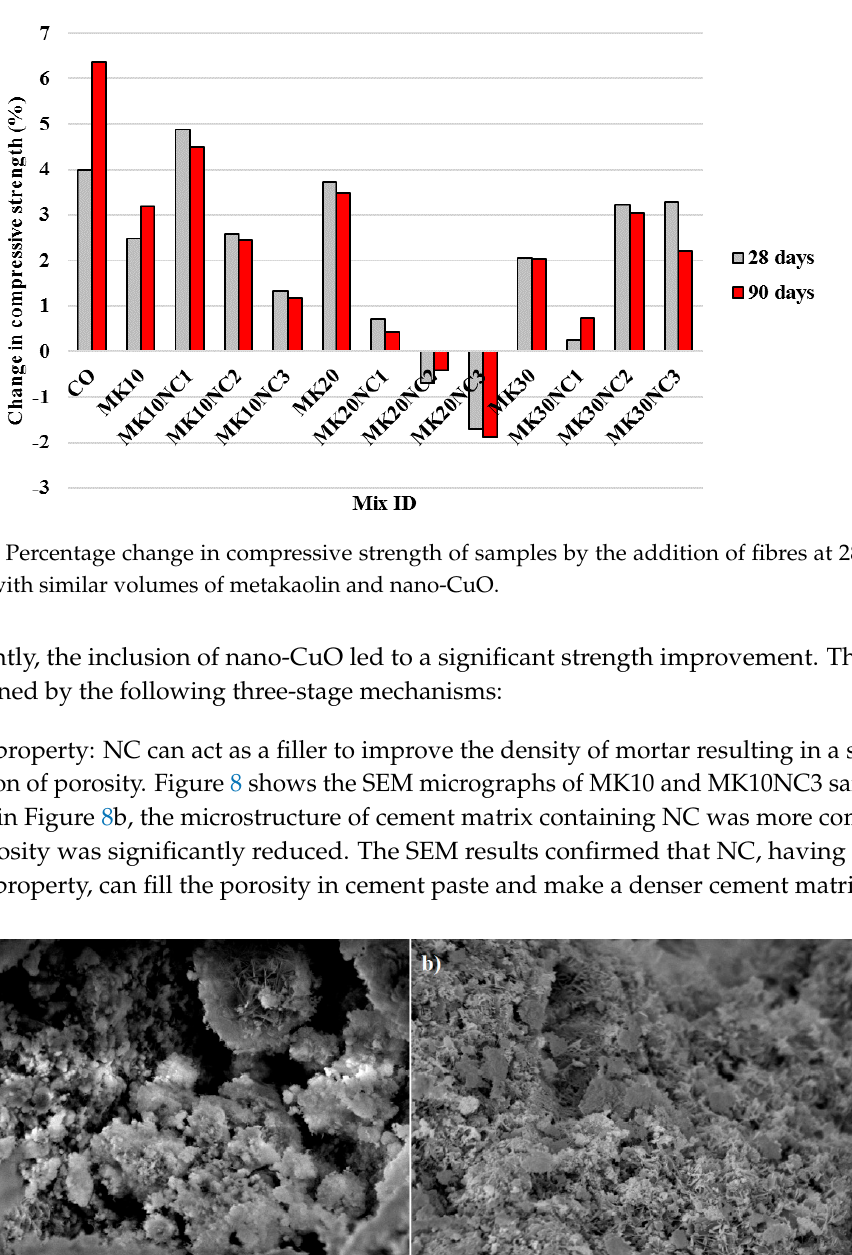
12 of 22 Figure 6. SEM images of: ( a ) CO sample; and ( b ) MK30 sample. According to previous studies, significant reaction between MK and Portlandite (CH) was shown within the interfacial transition zone (ITZ) between aggregate and cement paste. It was reported that the ITZ with a high concentration of large and aligated CH crystals would lead to localized areas of boosted porosity and lower strength [43,44]. Figure 6 shows the SEM micrographs of cement mortar containing 30 wt % MK compared to the control sample. As shown in Figure 5b, the microstructure of cement matrix with MK was more porous containing a large amount of needle- like hydration products cemented together. Moreover, the gap at the ITZ between the aggregate and cement paste found in MK cement sample was much bigger when compared to the control sample, and consequently the cement mortar containing MK showed a reduction in strength. Figure 7 also shows that the compressive strength of cement mortars generally increased slightly when 0.3% PP was used. Although the strengths for mixtures containing 20% MK and 2% or 3% NC were found decreased in comparison with mixes without PP, the average strength for all samples only increased by 2% at both 28 and 90 days. The strength improvement is considered insignificant and the results are similar to the findings of previous studies with other pozzolans where a significant